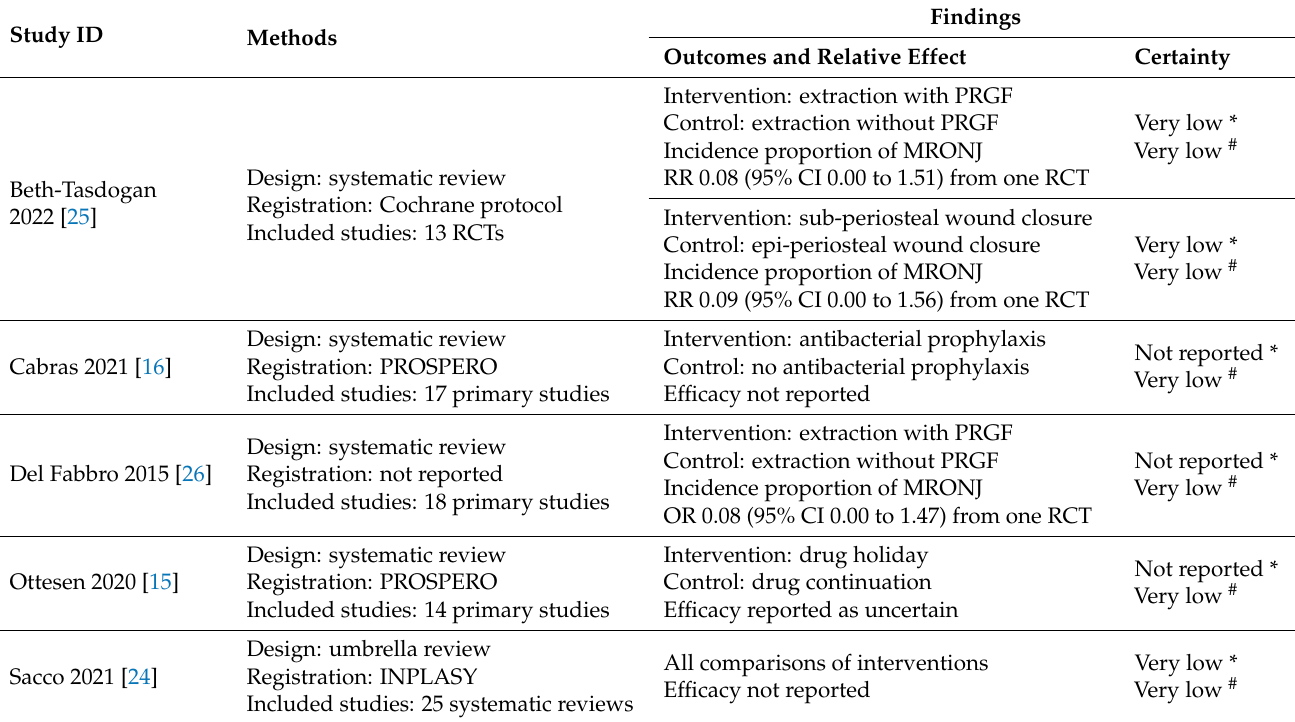
Table 3. Characteristics of included